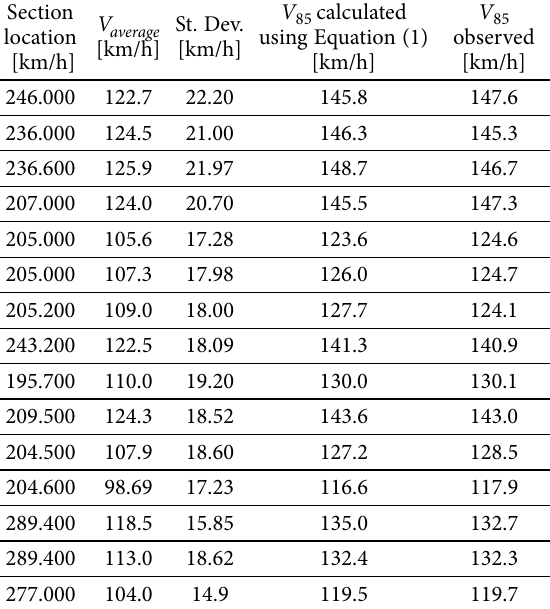
Table 4. Result of the ‘t-student’ test